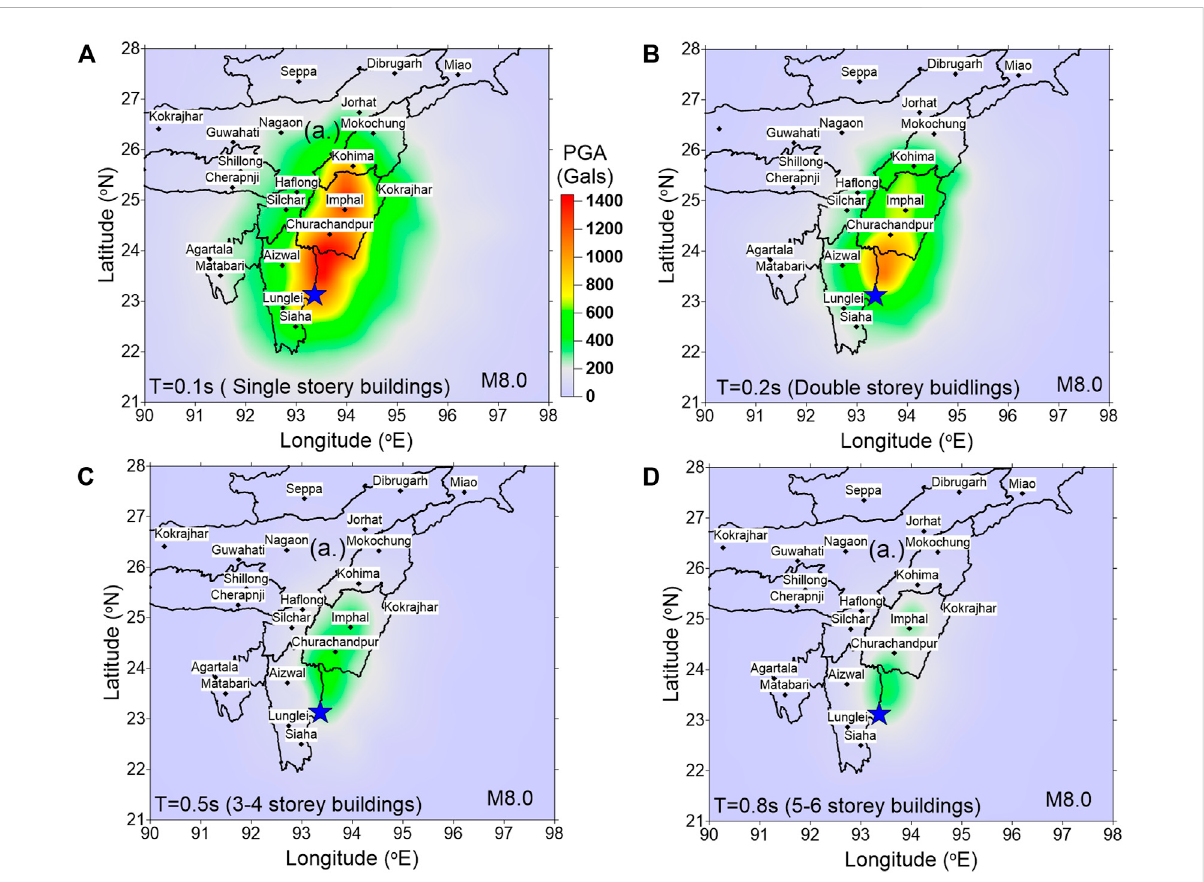
FIGURE 6 Contour plotfor thesimulated spectral acceleration for (A) single storey(T=0.1 s), (B) double storey (T=0.2 s), (C) 3-4storey, and (D) 5-6storey buildings are shown on the